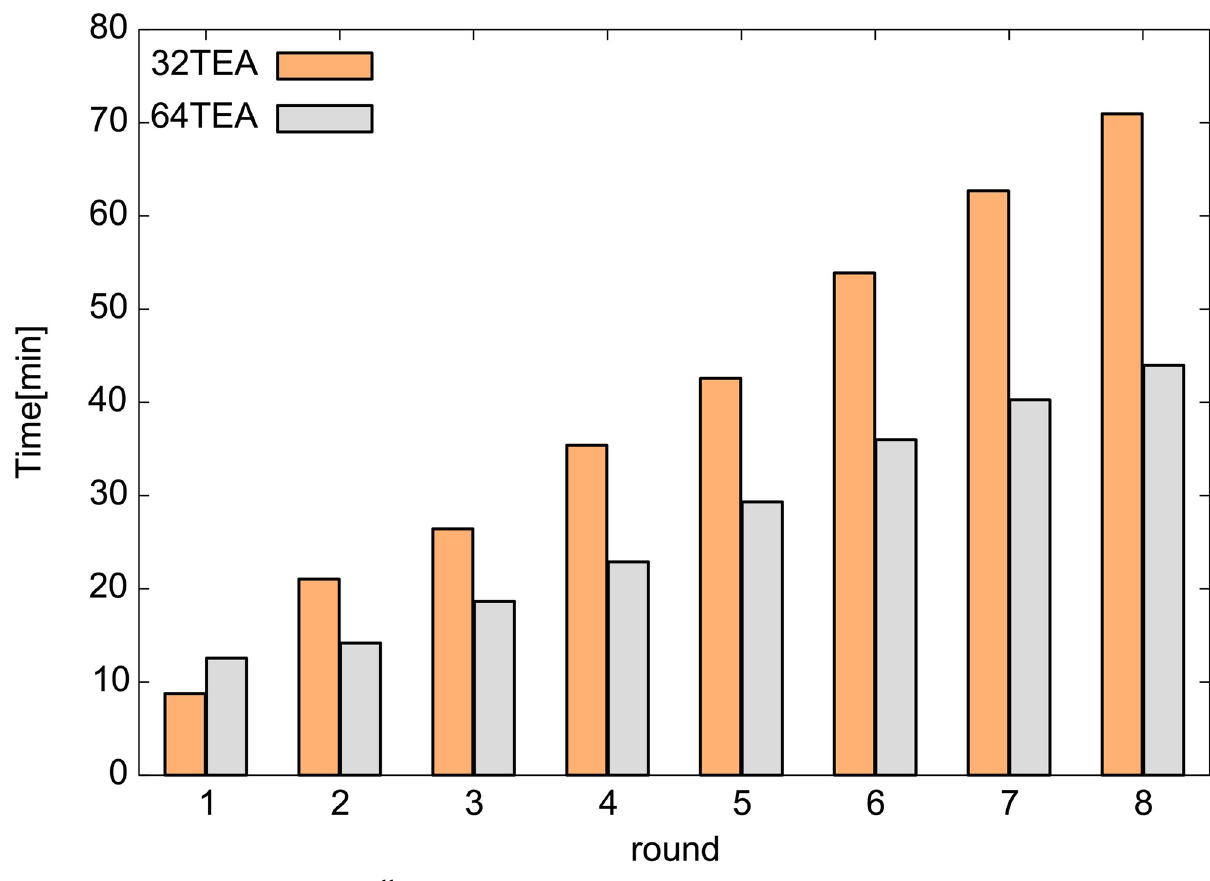
Fig 1. The required time to generate 1.0 × 10 11 random